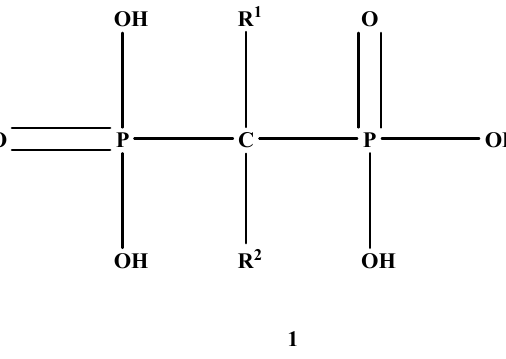
Figure 1. Structure of Bisphosphonate. Table 1. The structures of 3 generations of bisphosphonates. 2nd Generation 3rd Generation 1st Generation